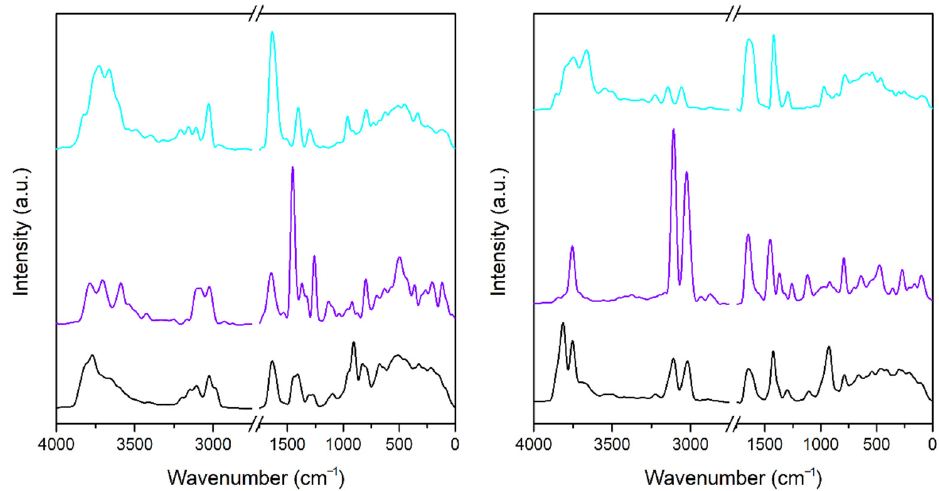
Figure 11. The calculated total VDOS (black) of A-TMP-Mt (left) and A-TMP-Bd (right), the calculated VDOS of the atrazine molecule (violet) and the calculated VDOS of water molecules in the interlayer (cyan).